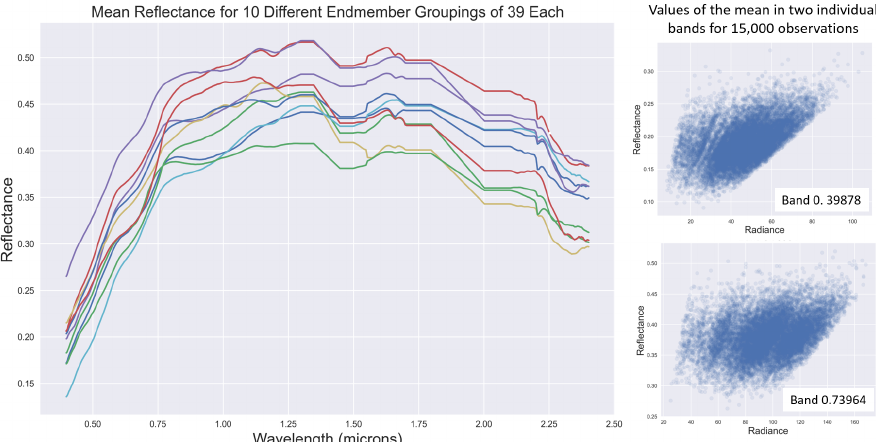
Figure 4. The mean reflectance spectrum for 10 different groupings of spectra ( left ) and the reflectance and radiance values in two different bands for the mean from 15,000 of our